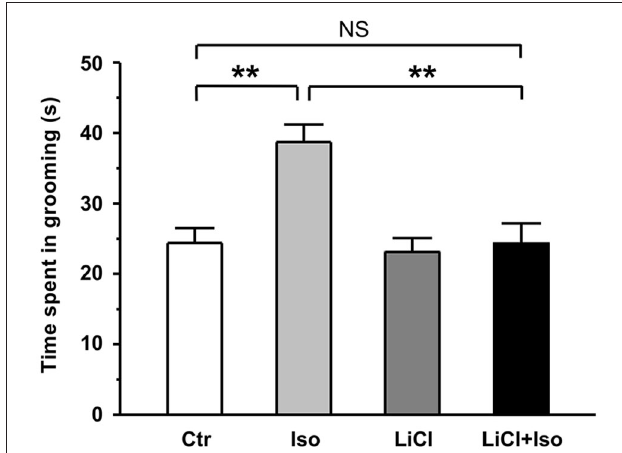
FIGURE 2 | Lithium reduces repetitive self-grooming behavior in neonatal isolation rats . The time spent in grooming is strongly increased in isolated rats during test, and lithium treatment restores the excessive grooming behavior to normal level. Two-way ANOVA analysis was used in this experiment. For repetitive self-grooming time: treatment × drug, F ( 1,135 ) = 4.214, P < 0.05; treatment, F ( 1,135 ) = 6.008, P < 0.05; drug, F ( 1,135 ) = 6.191, P < 0.05. Data show mean ± SEM (* p < 0.05; ** p < 0.01).